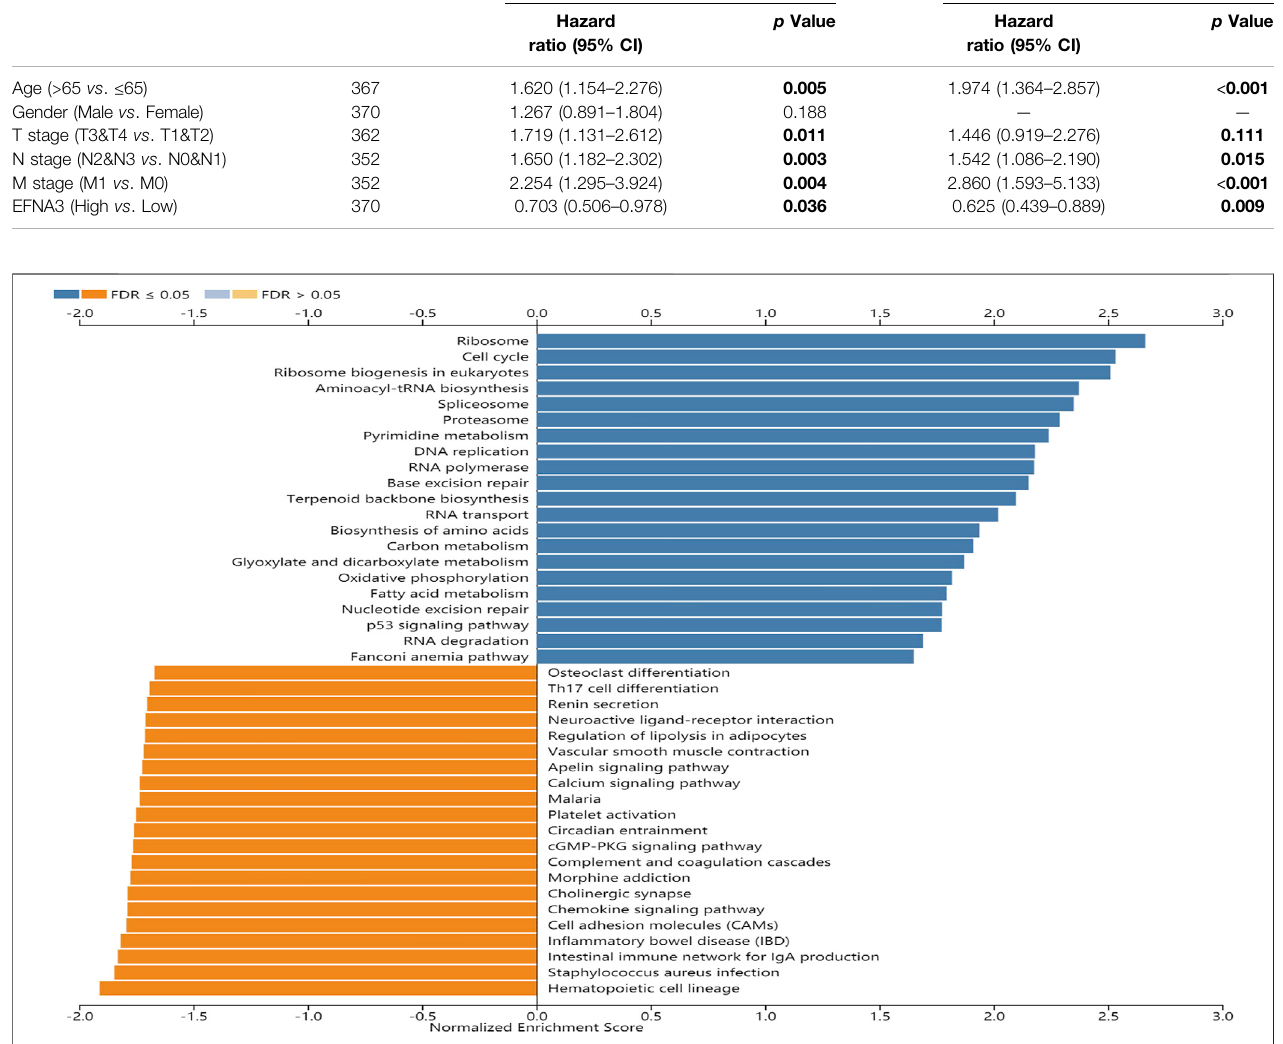
Frontiers in Genetics |